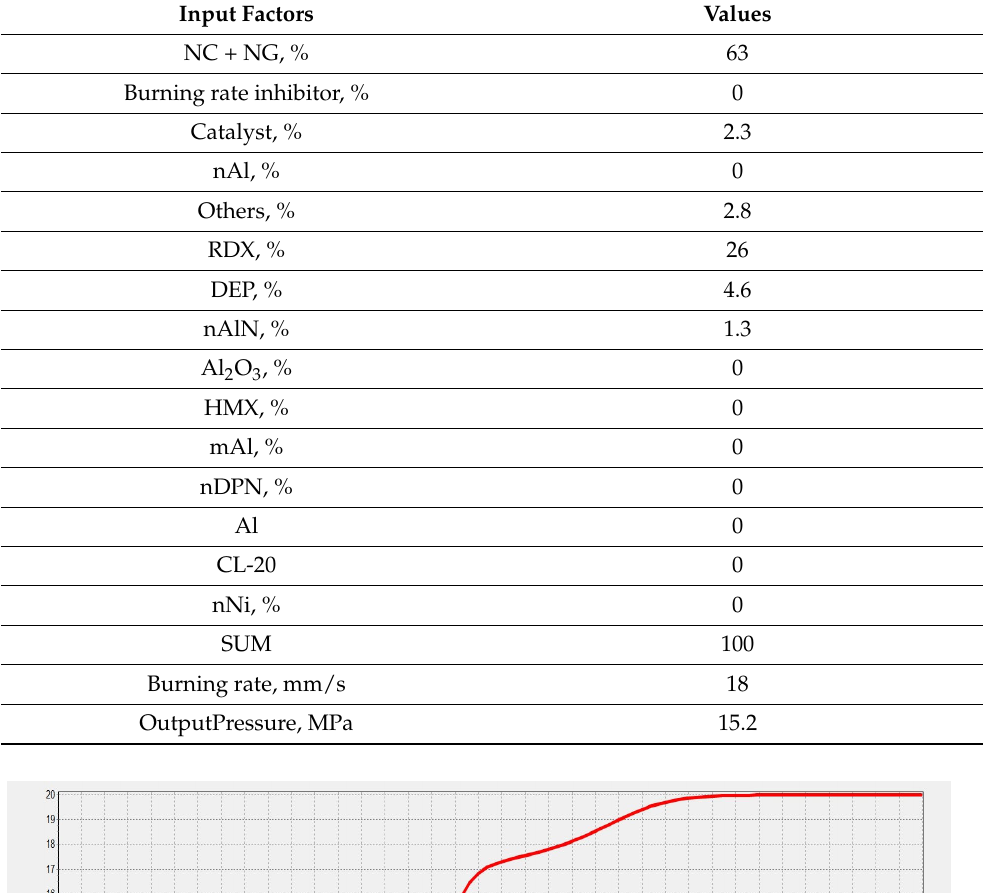
Table 2. The example of result of calculation of the ANN MCM that solves the inverse task.